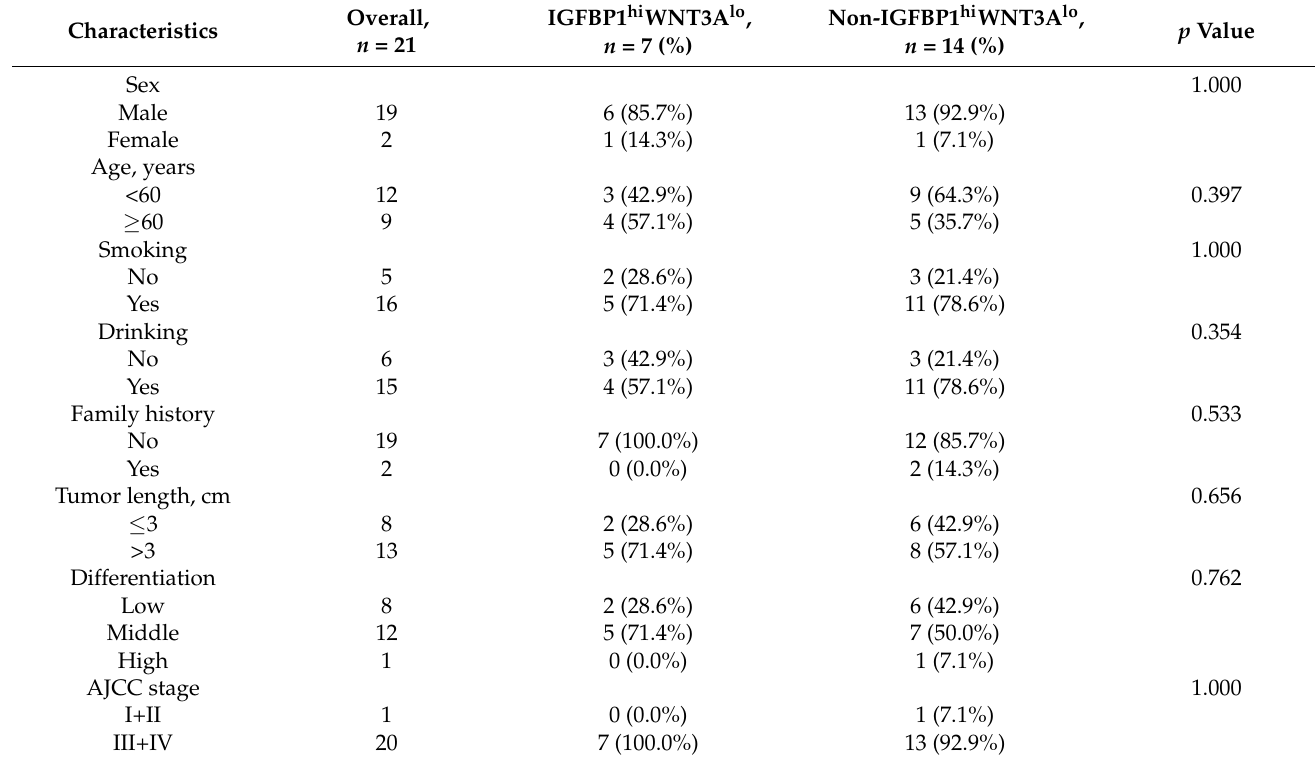
Table 1. Comparison of clinical characteristics in the BJIM